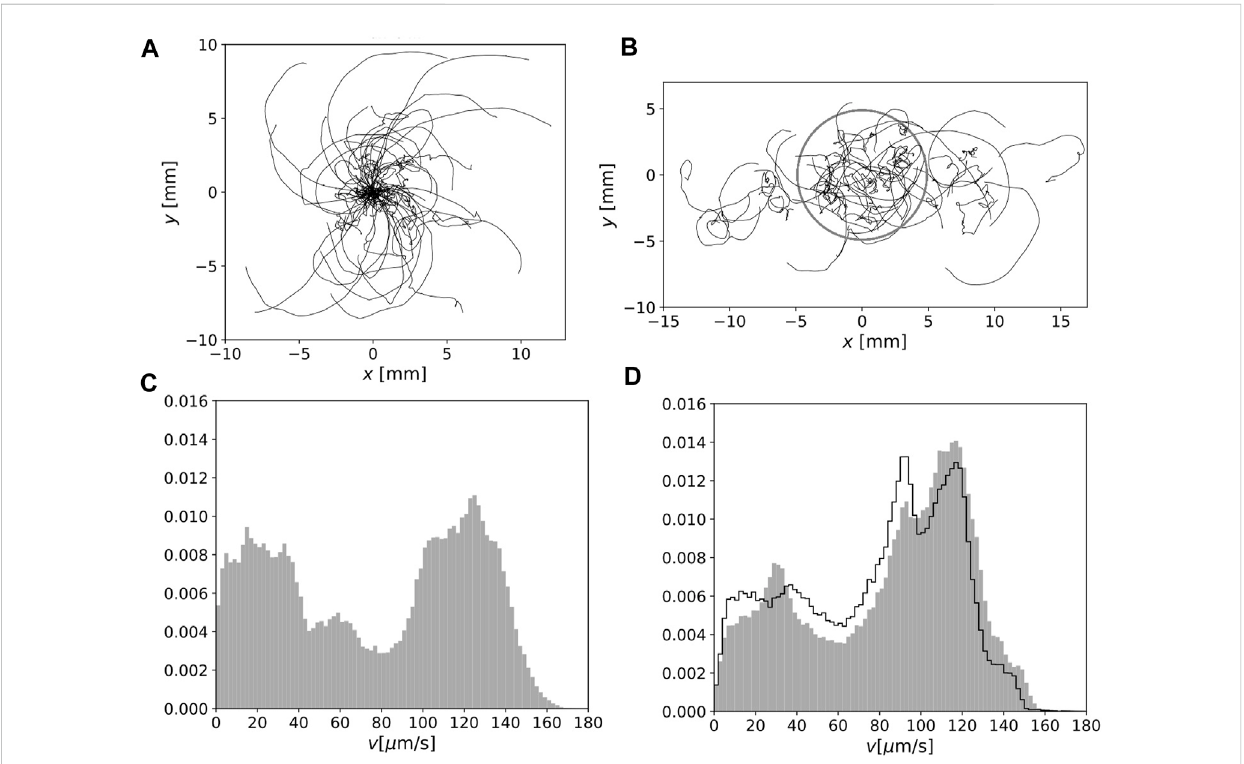
FIGURE 3 (A) Cell motion for 120 s in homogeneous environment. The initial positions were set at the origin. (B) As in (A) but under heterogeneous light conditionsinthelaboratoryframe.Theboundaryoftheredregionisindicatedbyagreycircle. (C) Normalizedspeeddistributionfor1s-averagedorbitsin a homogeneous environment. (D) As in (C) but in a heterogeneous environment. The normalized distribution of the speed of the orbits inside the red region is also indicated by the solid